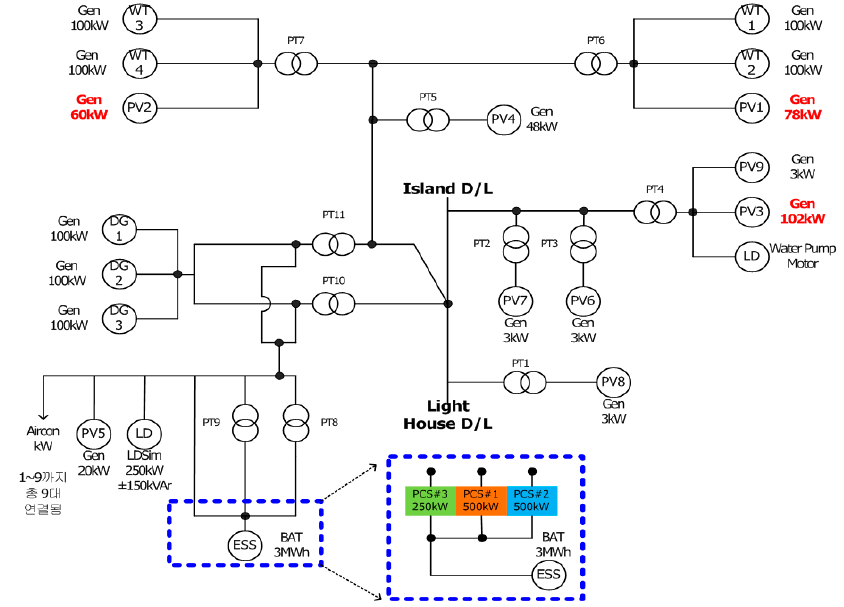
Figure 2. Power System of Ga-sa Island.